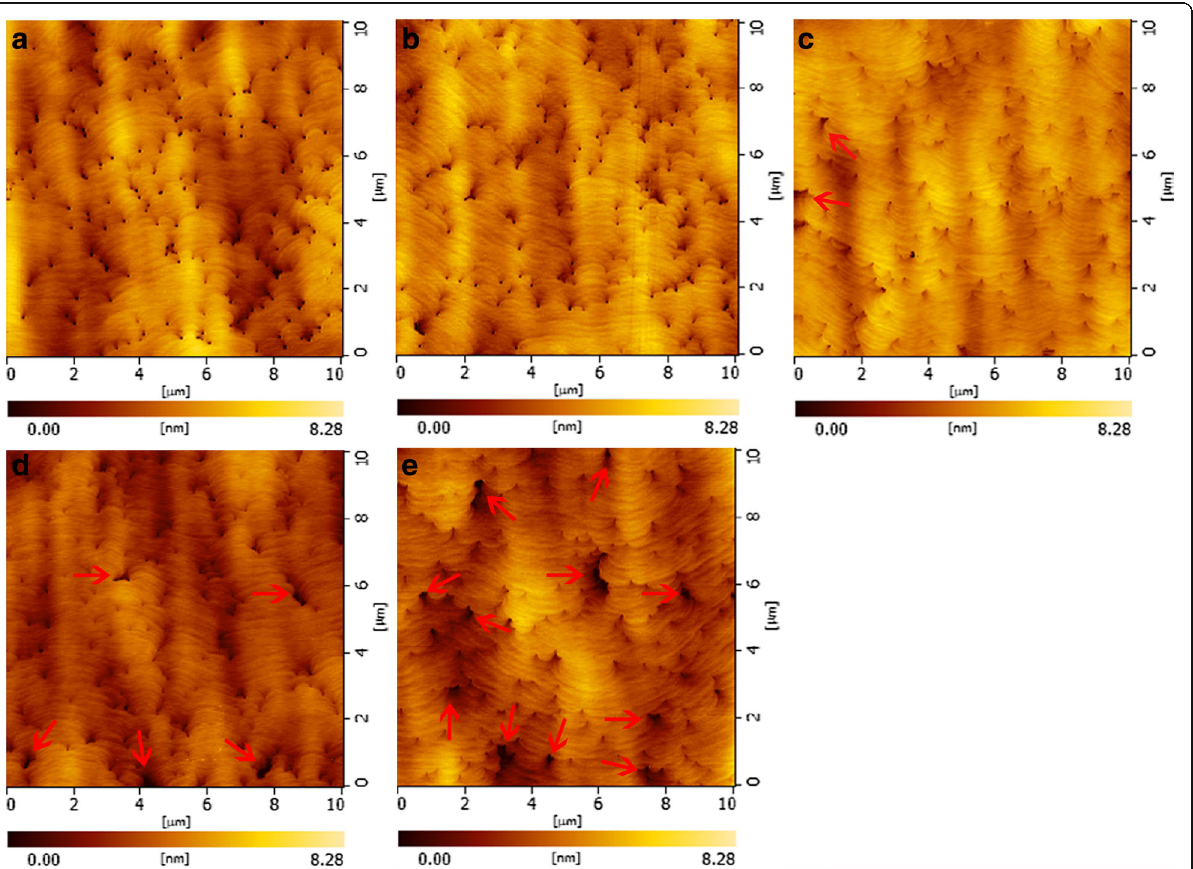
Fig. 2 The AFM images (10 × 10 μ m) of five samples: a S 1 , b S 2 , c S 3 , d S 4 , and e S